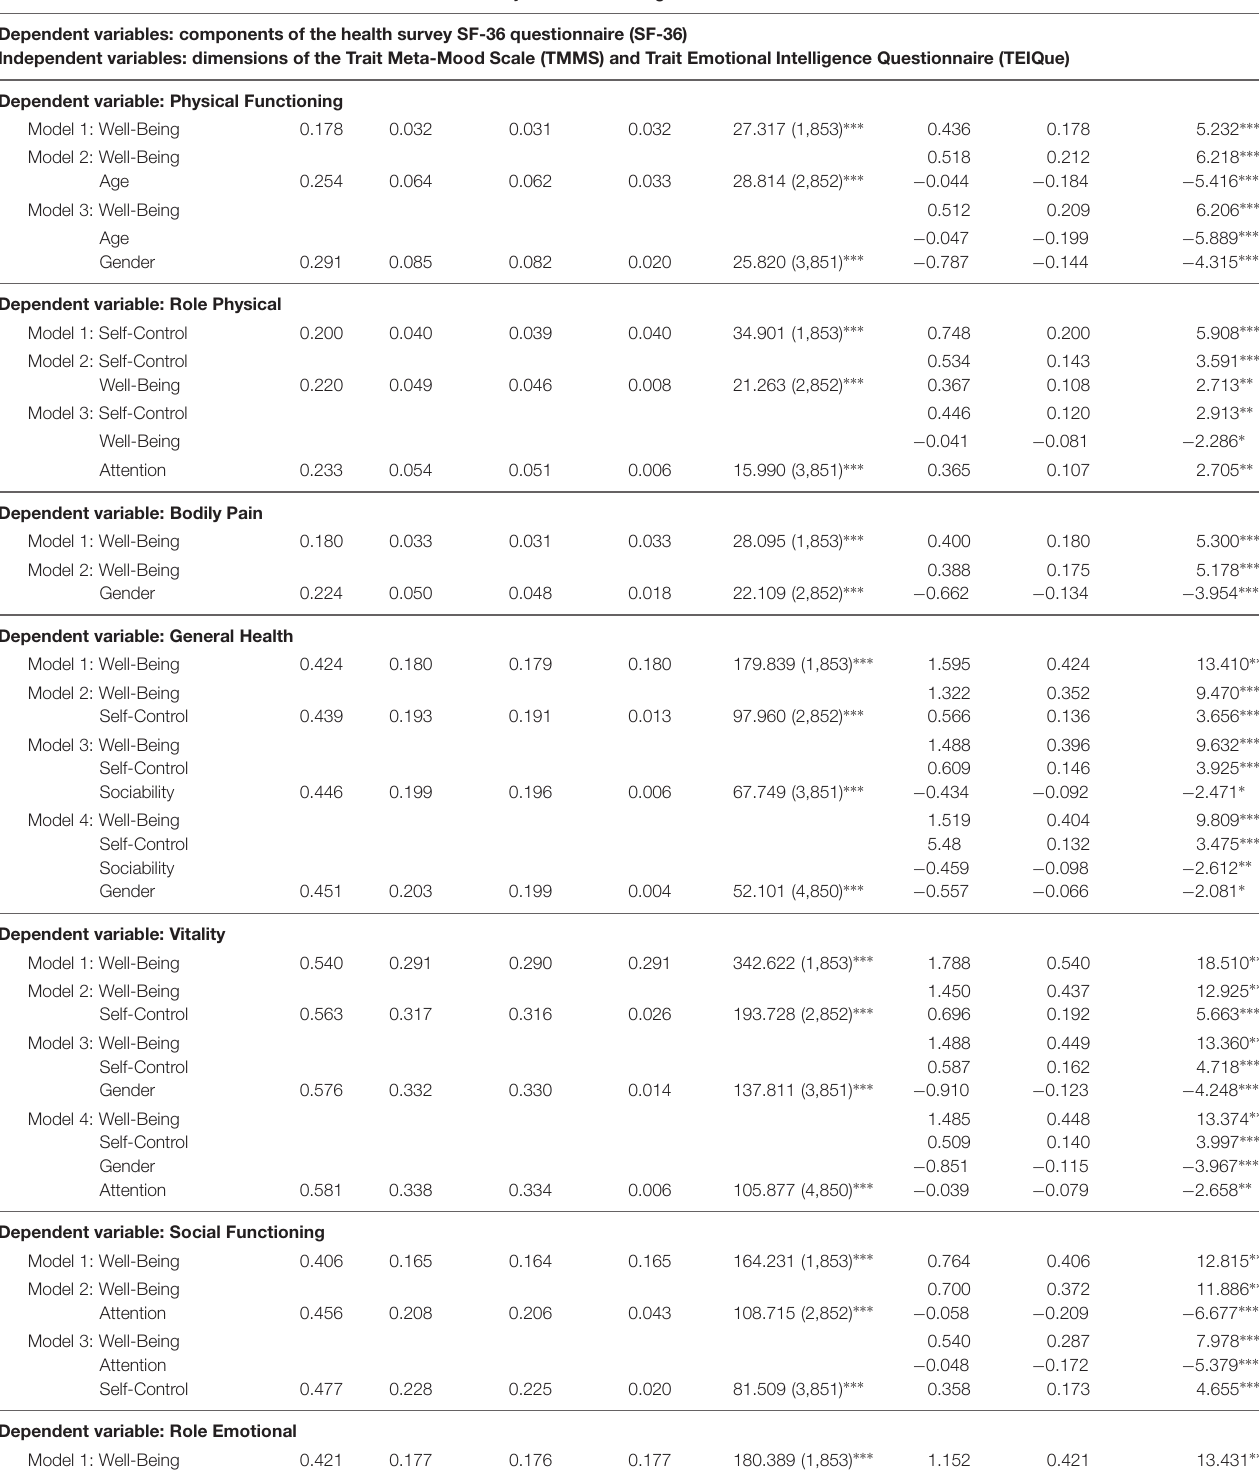
TABLE 3 | Stepwise multiple regression analysis.